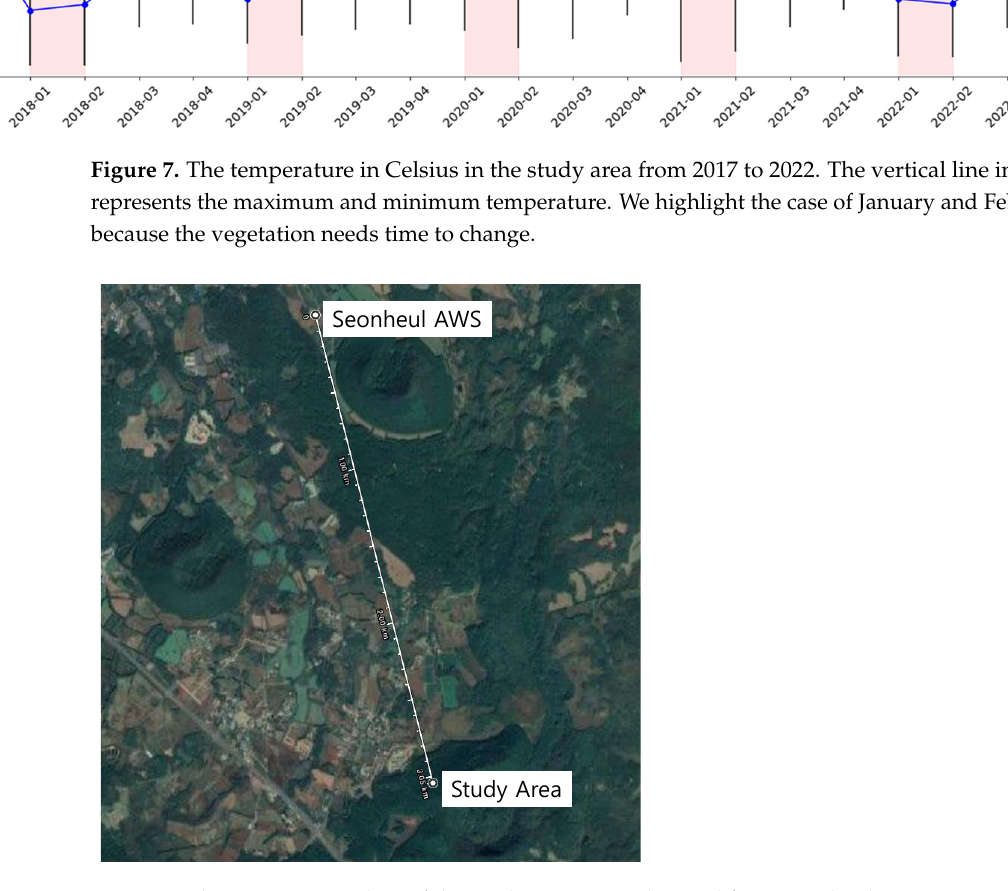
Figure 8. The temperature data of the study area were obtained from Seonheul Automatic Weather Station (AWS), which is 3 km away from the study area Assessing a region’s vegetation is essential to constructing an efficiently mixed forest.